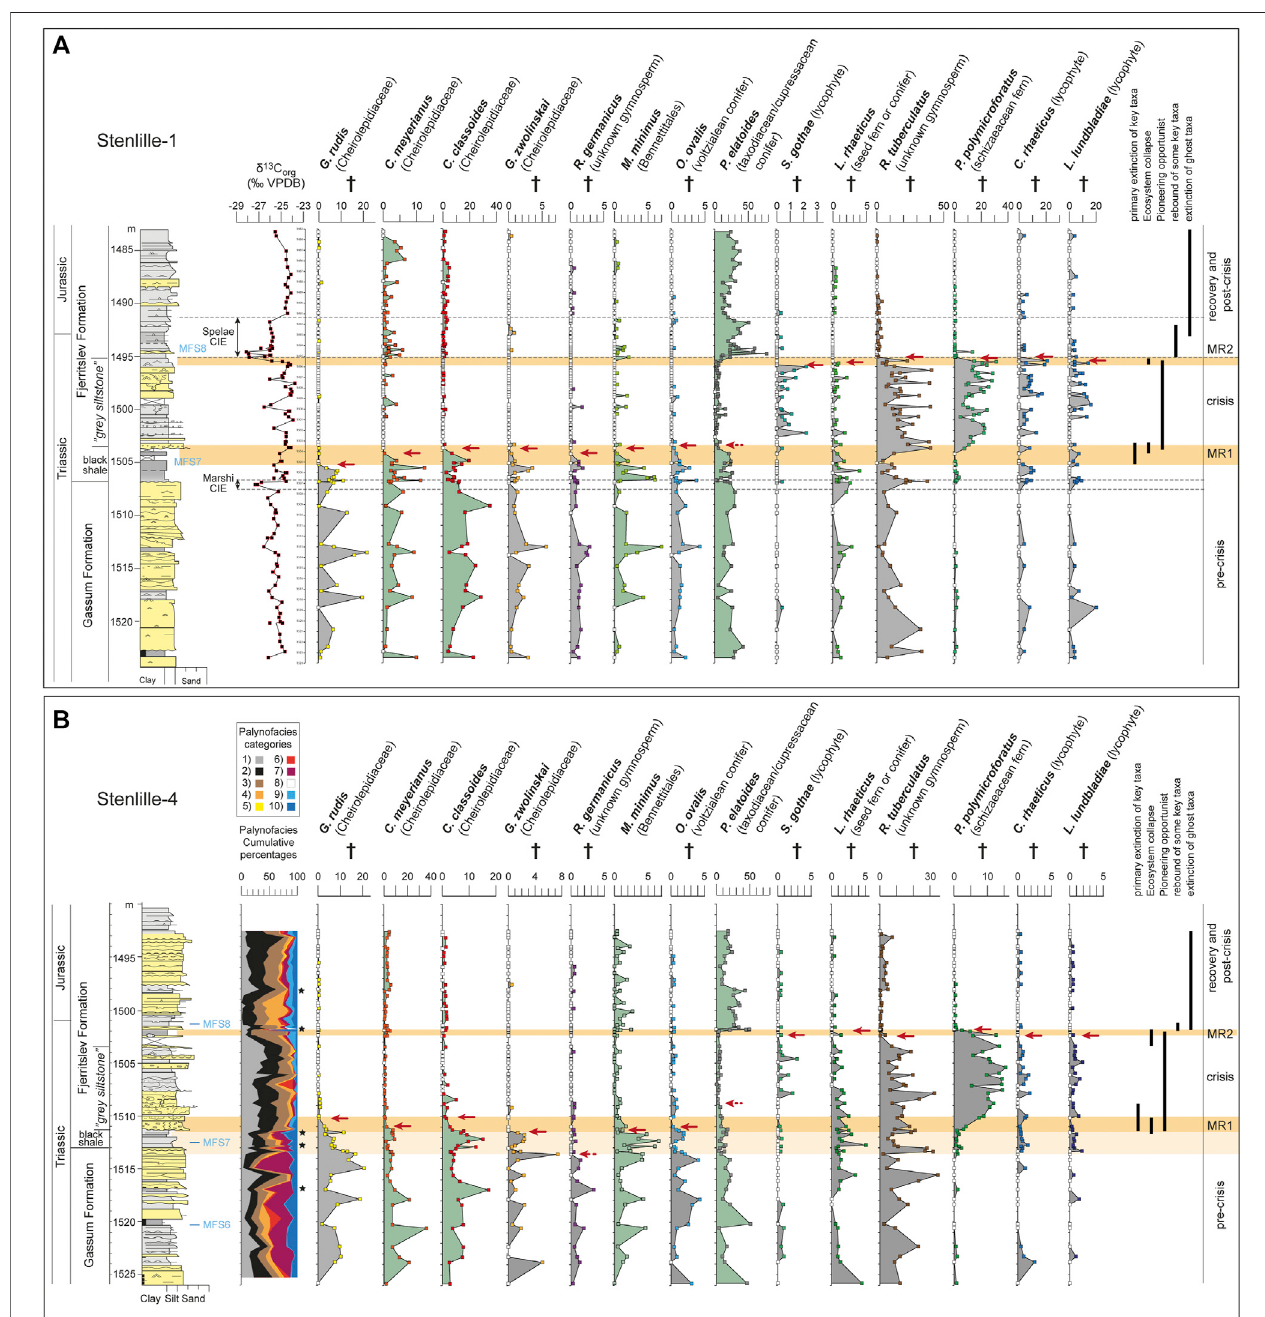
FIGURE 2 | Abundances of selected representative spore-pollen taxa in the Triassic – Jurassic boundary successions of the (A) Stenlille-1 and (B) Stenlille-4 cored wells. (A) also displays the δ 13 C org record of Stenlille-1, the position of the Marshi and Spelae CIEs, and of the maximum fl ooding surfaces (Nielsen, 2003, Lindström et al., 2021). (B) also shows the cumulative percentages of palynofacies categories: 1) black opaque clasts, 2) black wood remains, 3) brown wood remains, 4) plant tissue, 5) cuticles, 6) Amorphous organic matter, 7) marine phytoplankton, 8) freshwater microalgae, 9) spores, 10) pollen. The spore-pollen counts for Stenlille-1 and -4 are listed in Supplementary Tables S1, S2 , respectively. Black stars mark observations of char.